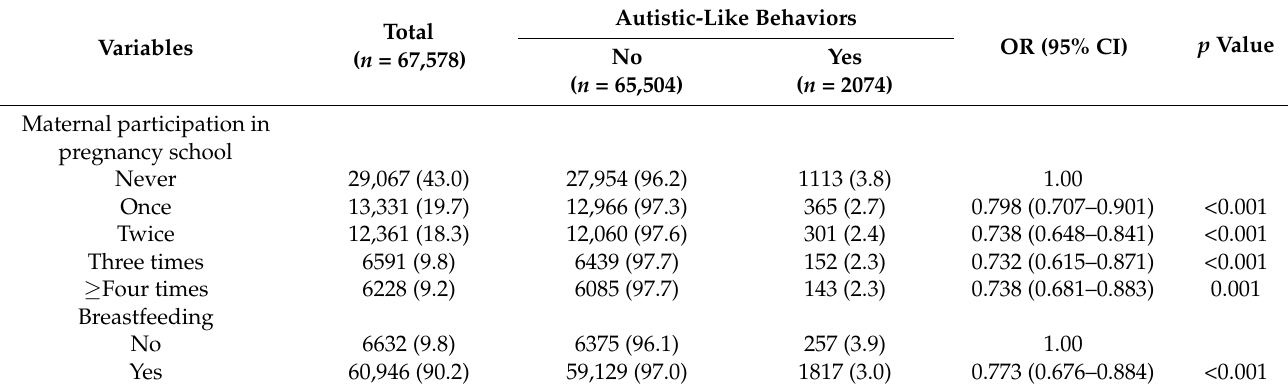
Table 5. Association of maternal participation in pregnancy school variables and breastfeeding with autistic-like behaviors of preschool children # .